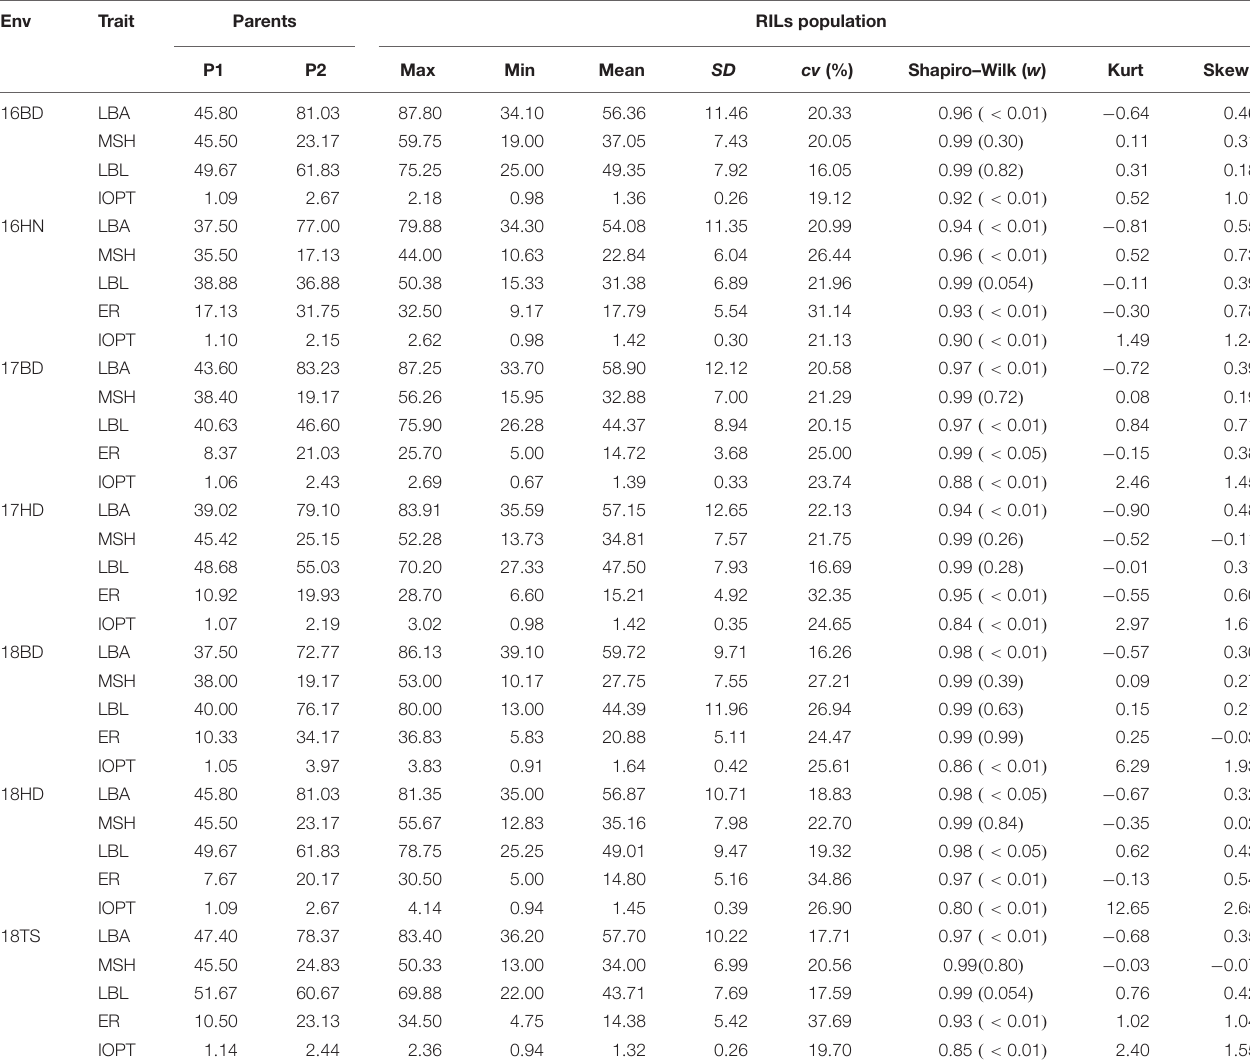
TABLE 1 | Phenotypic variation for five traits of the RILs and their parents in seven environments.